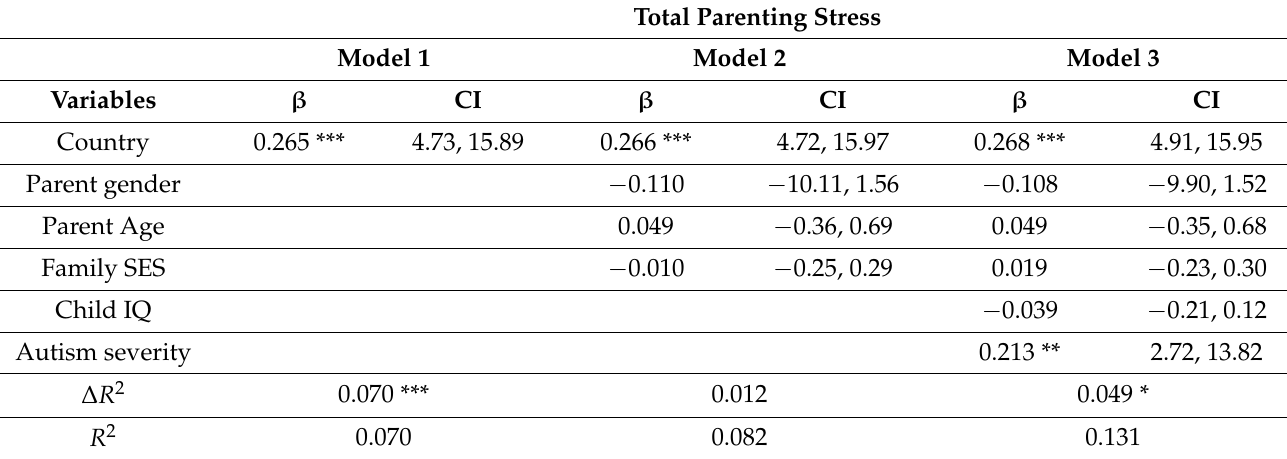
Table 3. Hierarchical regression predicting total parenting